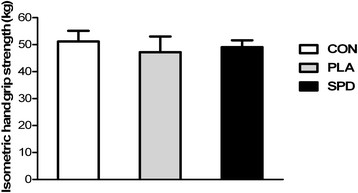
Mean (±SD) isometric hand grip strength with the dominant hand in the 3 conditions (CON, PLA and SPD). Inter-group analysis was carried out using the Kruskal-Wallis one-way analysis; no statistical difference was found.